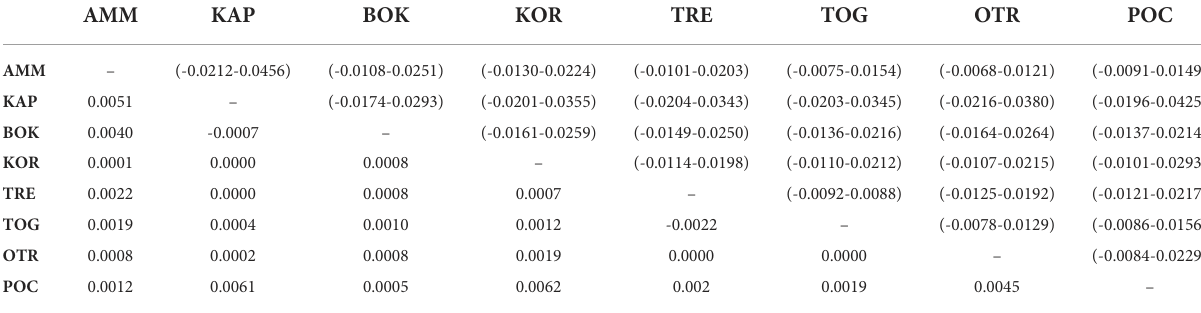
TABLE 5 Pachygrapsus marmoratus pairwise genetic differentiation measured as Jost ’ s D based on 14 neutral